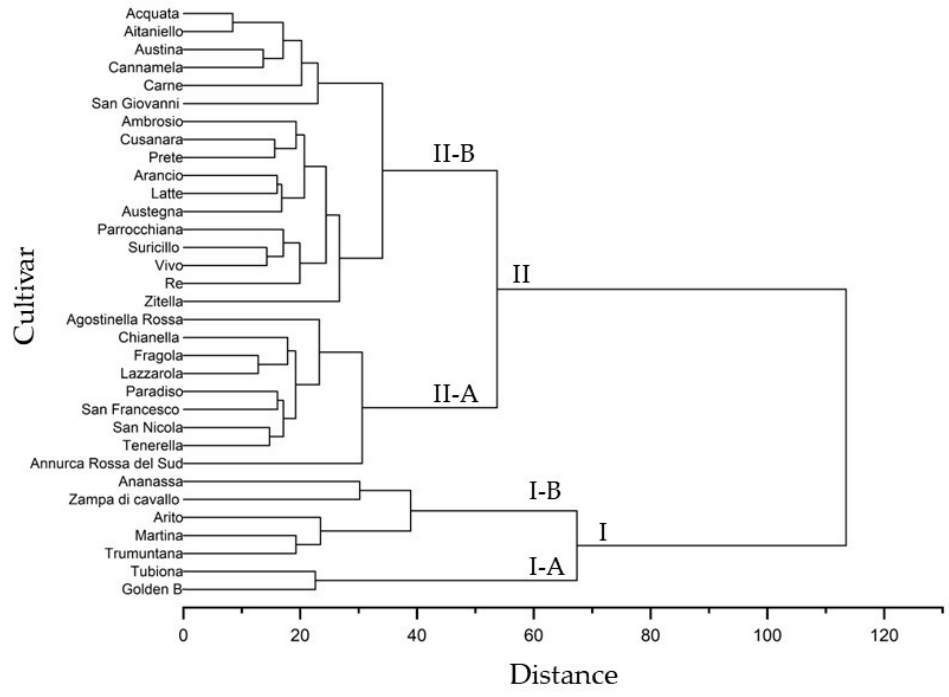
Figure 4. Cluster analysis of morphological, pomological and physicochemical parameters in the thirty-one autochthonous apple cultivars and two commercial cultivars (‘Golden b’ and ‘Annurca Rossa del Sud’).